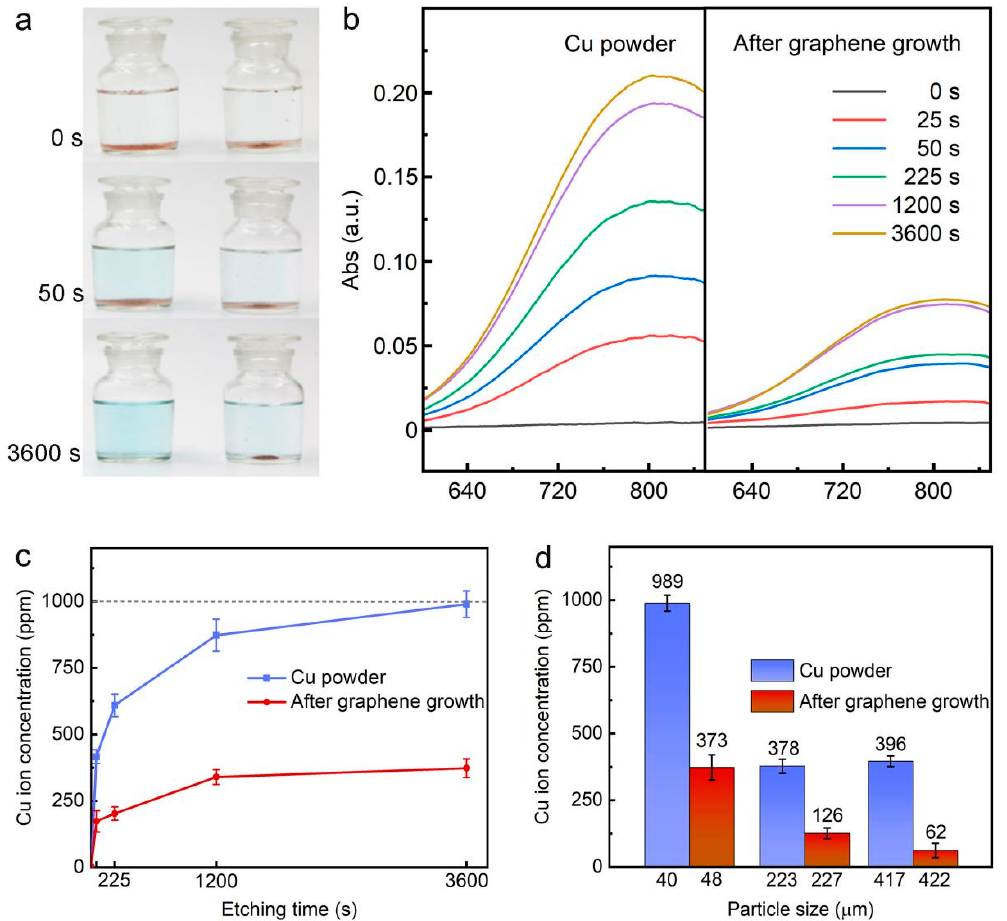
Figure 4. ( a ) Color evolution of Cu powder and Gr/Cu microparticles immersed in Cu etchant (0.5 M ammonium persulfate (APS) solution); ( b ) the comparison of UV-Vis absorption spectra; ( c ) the corresponding dissolved Cu 2+ concentrations as a function of etching time; ( d ) the superior corrosion resistance property of Gr/Cu microparticles with different sizes.